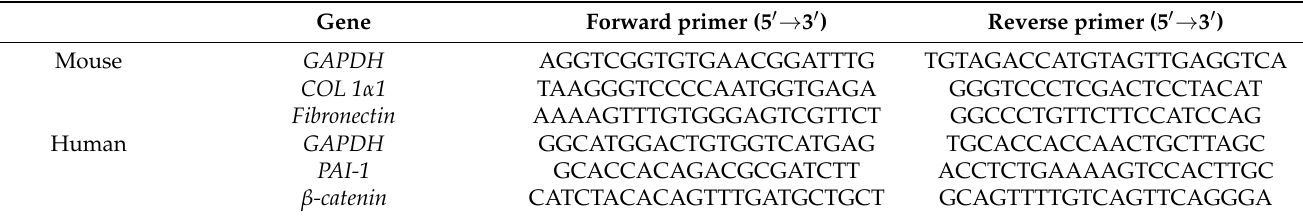
Table 1. Primers used in